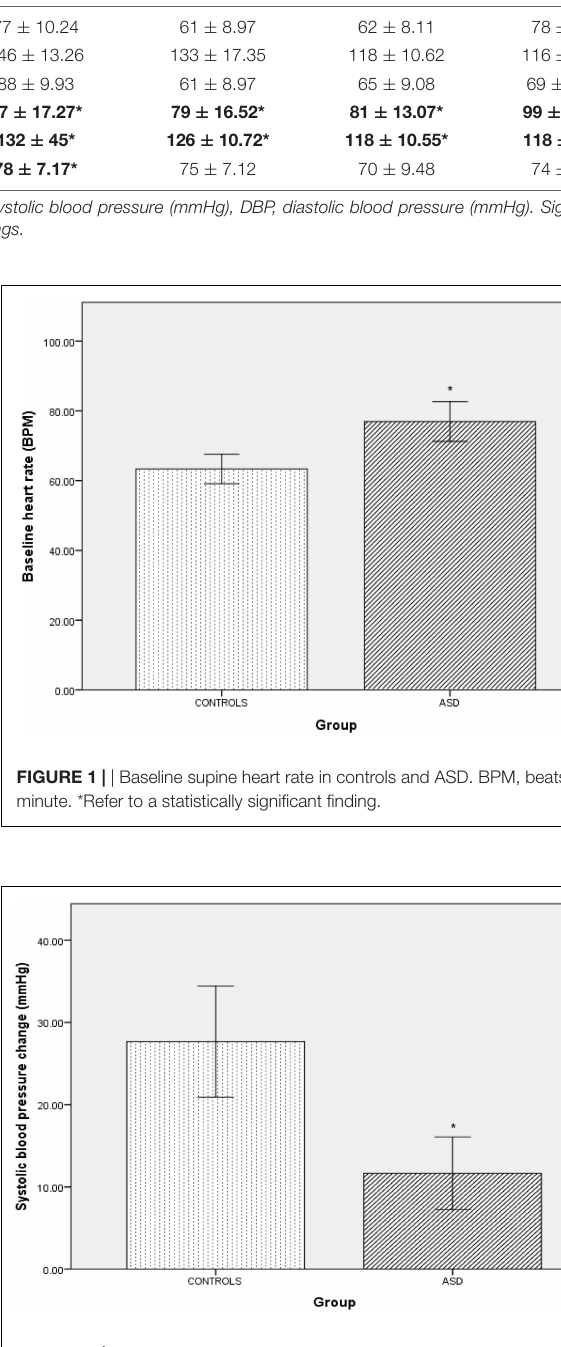
FIGURE 2 | Changes in mean systolic blood pressure from baseline during isometric exercise in controls and ASD. mmHg, millimeters of mercury. *Refer to a statistically significant